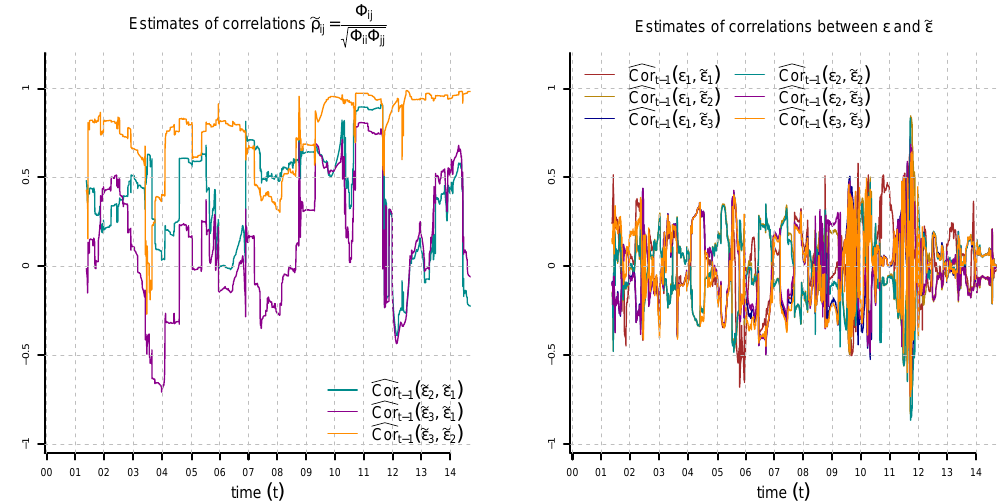
Figure 18. Estimation of correlations (cid:101) ρ 21 , (cid:101) ρ 31 and (cid:101) ρ 32 (lhs) and correlations Cor [ ε ( t ) , (cid:101) ε ( t ) | F ( t − 1 )] (rhs). We use a time window of 252 observation for the regression. The residuals ε are calculated using the parameter estimates of Figures